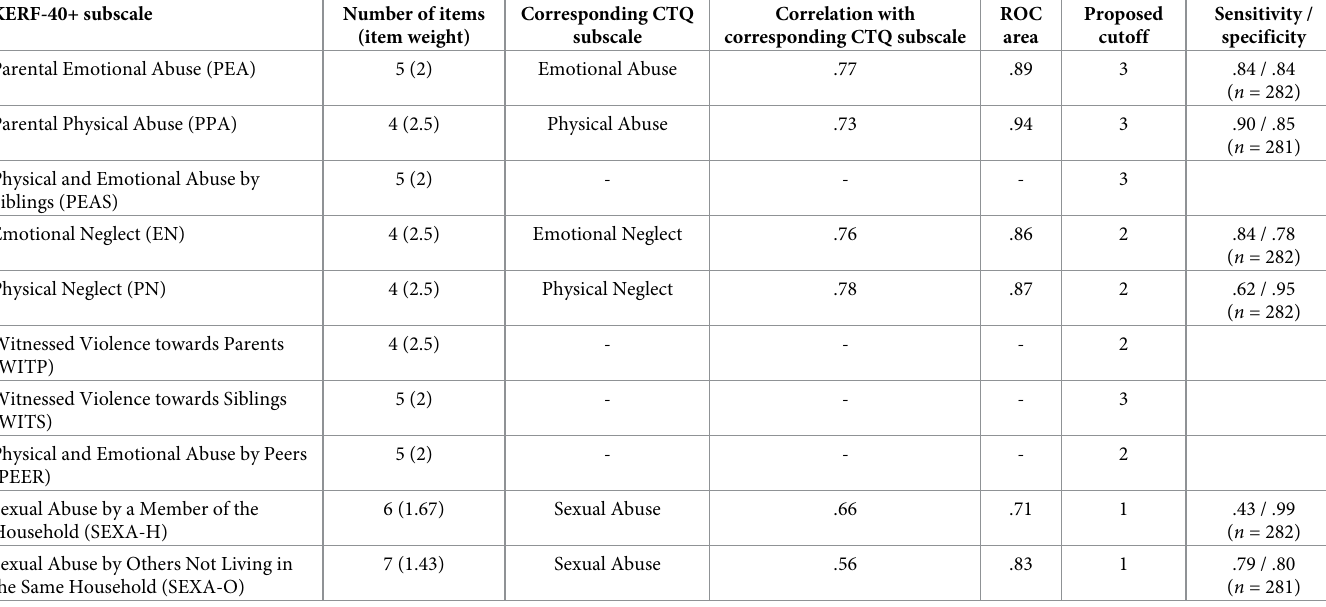
Table 4. Receiver operating characteristic, sensitivity and specificity analysis of the KERF-40+.